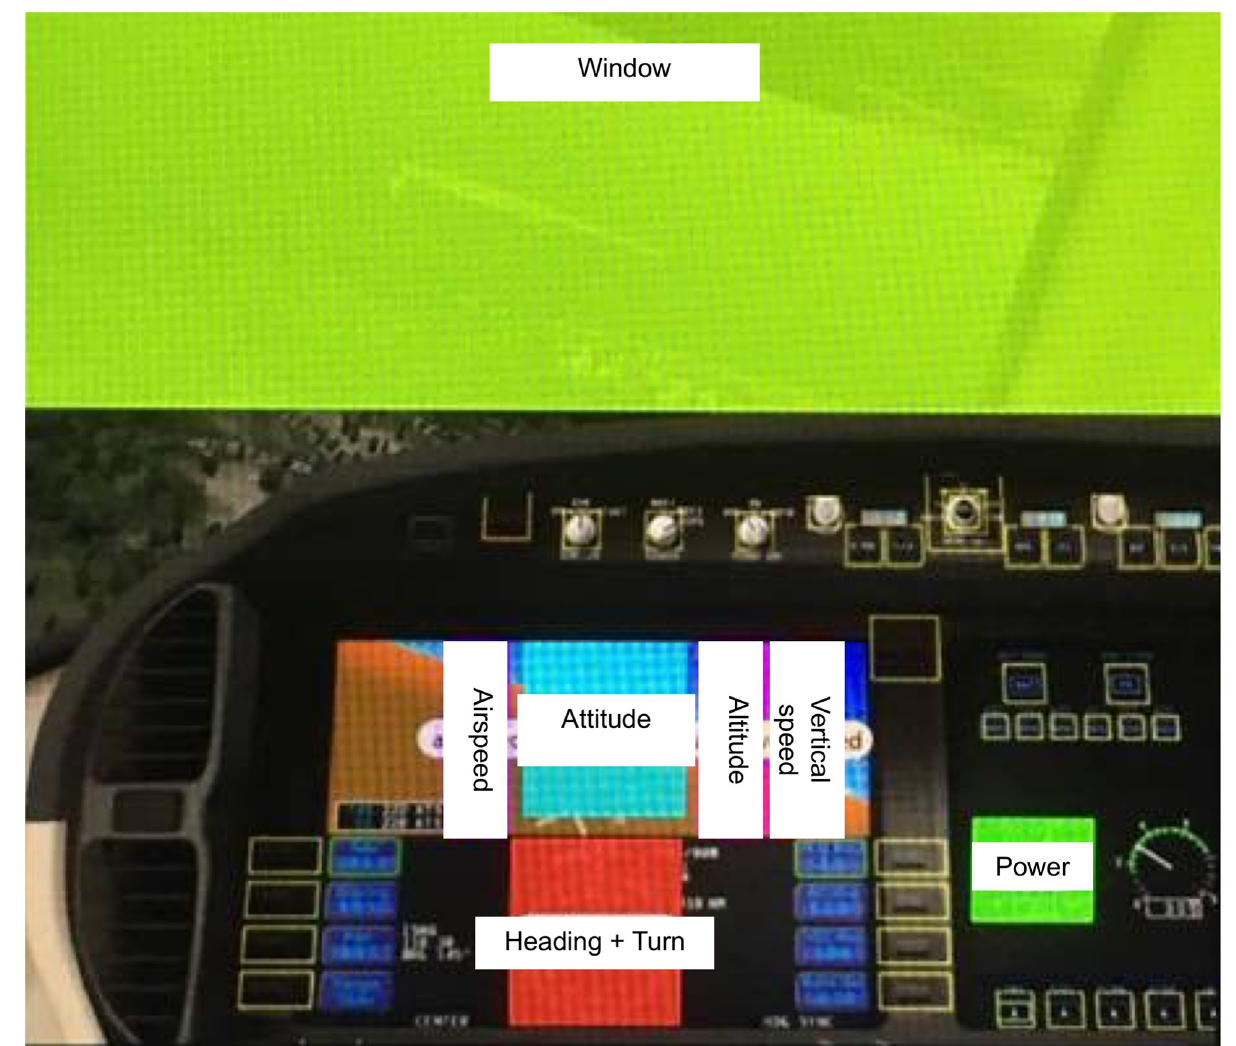
Fig 1. Overview of the different AOI’s: Window (green), Airspeed (purple), Attitude (blue), Altitude (pink), Vertical speed (orange), Heading + turn (red) and Power (green in right corner).